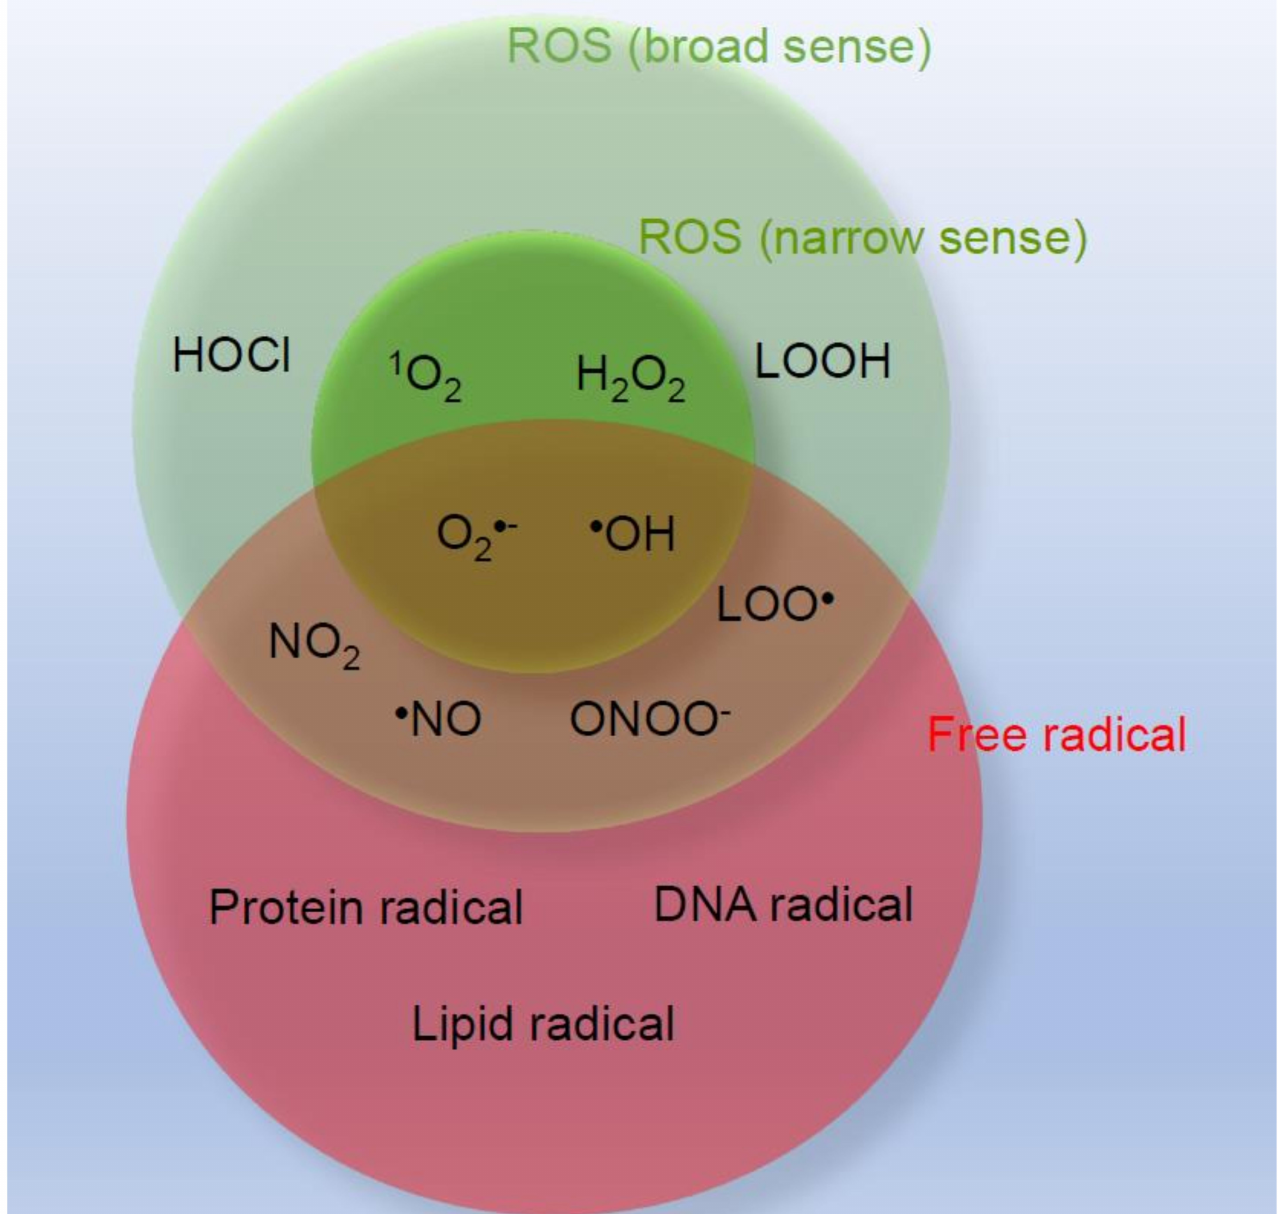
Figure 1. Reactive oxygen species and free